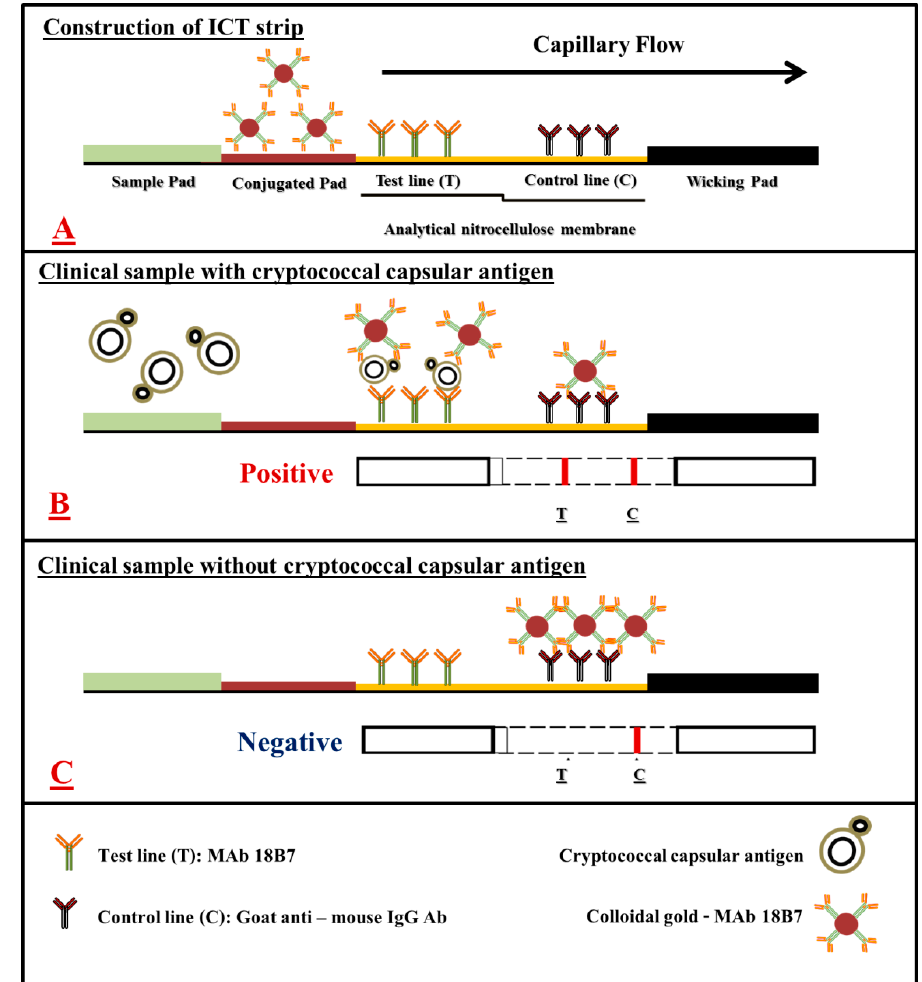
Figure 1. A schematic of mAb 18B7 sandwich ICT strip for the rapid detection of cryptococcal capsular antigen from clinical samples. ( A ), the schematic presentation of the positions where colloidal gold conjugated mAb 18B7, mAb 18B7 and goat anti-mouse IgG antibodies are immobilized in an analytical nitrocellulose membrane. ( B ), the reactions that occur on the mAb 18B7 sandwich ICT strip in the presence of cryptococcal capsular antigen and ( C ), in the absence of cryptococcal capsular antigens. The red–purple color of colloidal gold conjugate appears at the test line and/or control line, depending on the presence or absence of cryptococcal capsular antigen in the clinical